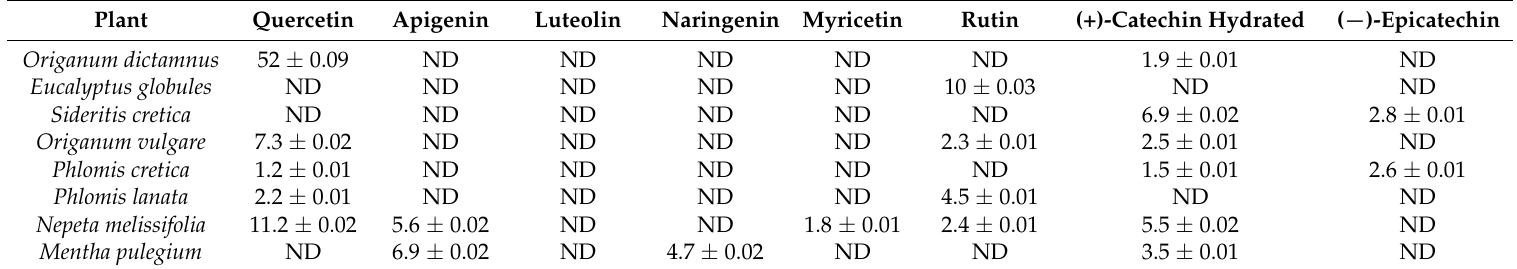
Table 4. Flavonoid content in the examined plant extracts (expressed in mg/100 g dry sample a ).